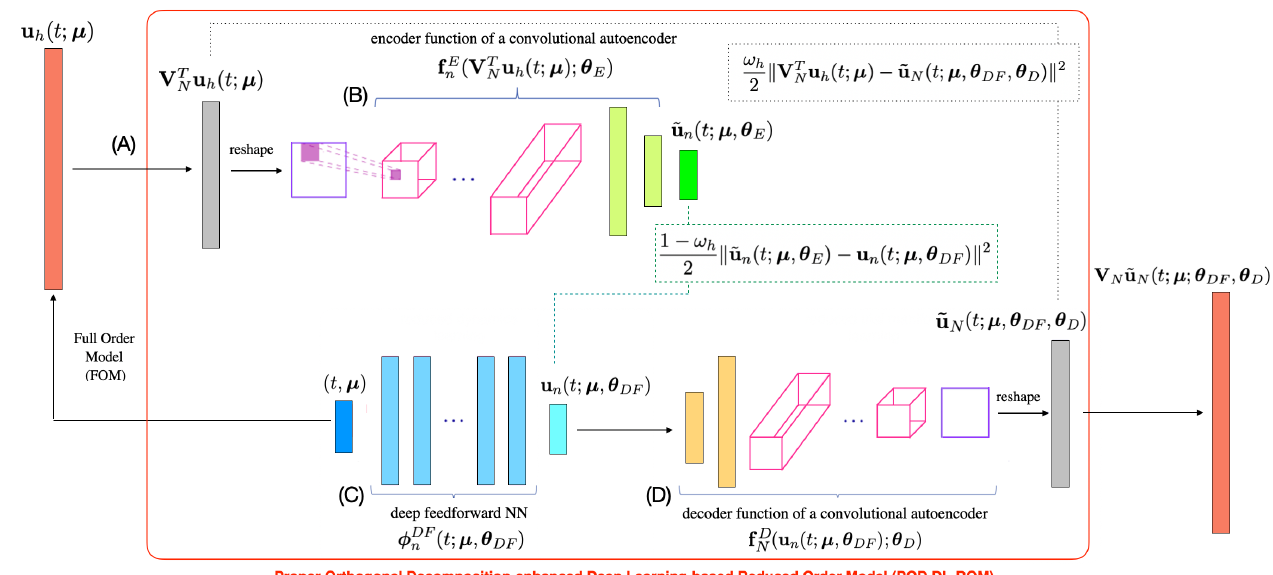
Figure 1. POD-DL-ROM architecture. Starting from the FOM solution u h ( t ; µ ) , the intrinsic coordinates V T computed by means of rSVD; their approximation ˜u N ( t ; µ ) is provided by the neural network as output so that the reconstructed solution ˜u h ( t ; µ ) = V N ˜u N ( t ; µ ) is recovered through the rPOD basis matrix. In particular, the intrinsic u h ( t ; µ ) are provided as input to block ( B ) which outputs ˜ u n ( t ; µ ) . The same parameter instance associated coordinates V T N to the FOM, i.e., ( t ; µ ) , enters block ( C ) which provides as output u n ( t ; µ ) , and the error between the low-dimensional vectors is accumulated. The minimal coordinates u n ( t ; µ ) are given as input to block ( D ) returning the approximated intrinsic coordinates ˜u N ( t ; µ ) . Then, the reconstruction error is